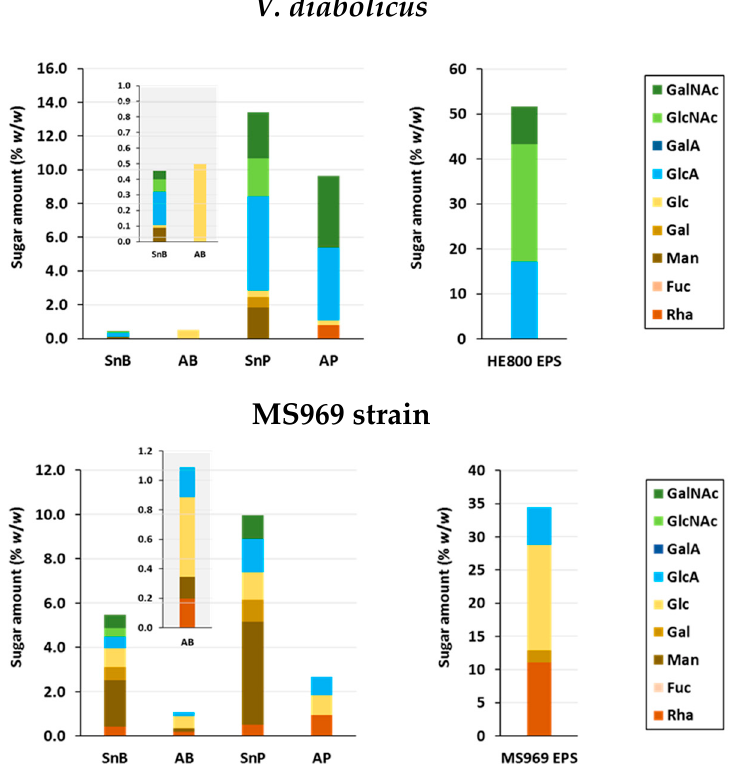
Figure 7. Osidic composition (% w / w ) of V. diabolicus and MS969 extracts. GalNAc: N-Acetylgalactosamine, GlcNAc: N-Acetylglucosamine, GalA: Galacturonic acid, GlcA: Glucuronic acid, Glc: Glucose, Gal: Galactose, Man: Mannose, Fuc: Fucose, Rha: Rhamnose. Added inserts zoom on extracts containing low level of sugars. The osidic composition of EPS produced in the presence of 30 g/L glucose is indicated for both strains [54].